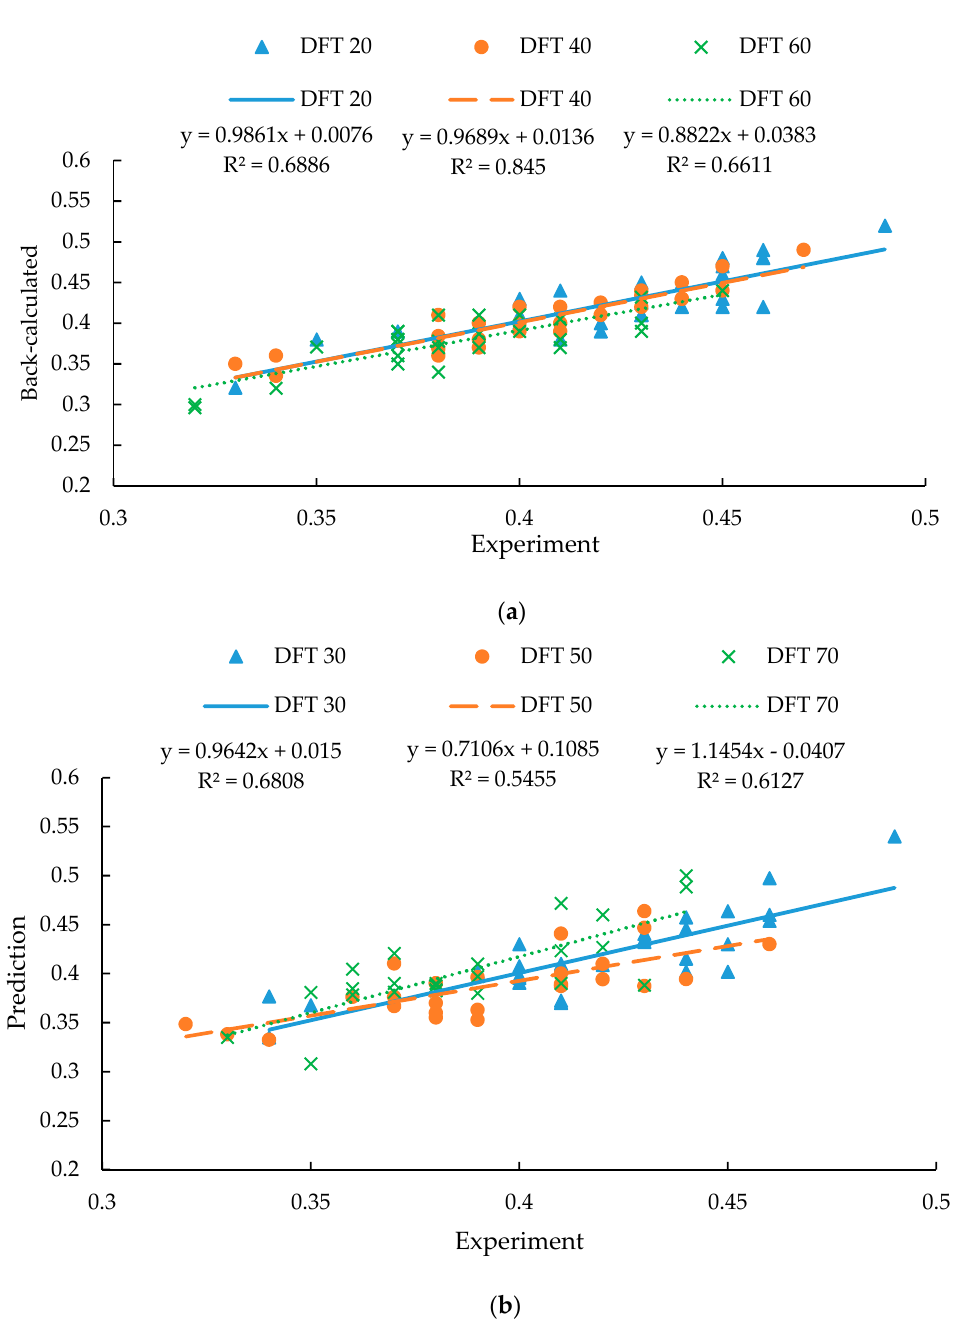
Figure 10. Validation of the back-calculated results: ( a ) Back-calculated results vs experimental data; ( b ) Predicted results vs experimental data.